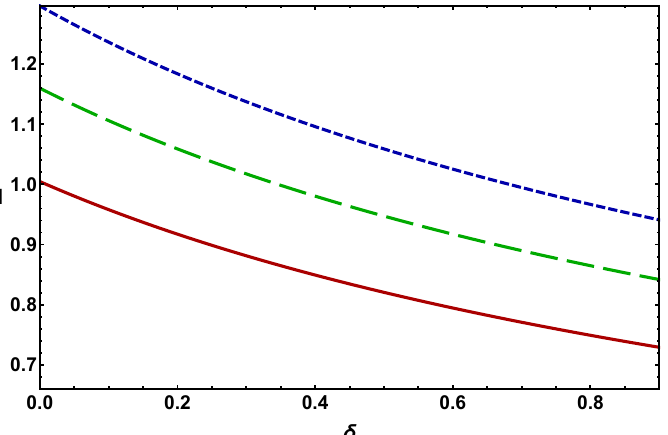
Figure 1. The variation in phase velocity ( M ) of NAWs in magneto-rotating cold degenerate plasma ( σ Te = 0) for non-relativistic electron or γ e = 5/3 (blue dotted curve), ultra-relativistic electron or γ e = 4/3 (green dashed curve), relativistic electron or γ e = 1 (red solid curve), where θ = 0.5 ◦ , Ω Ω = 0.03, l x = 0.2, and σ = 0. c = 0.05, Te 0